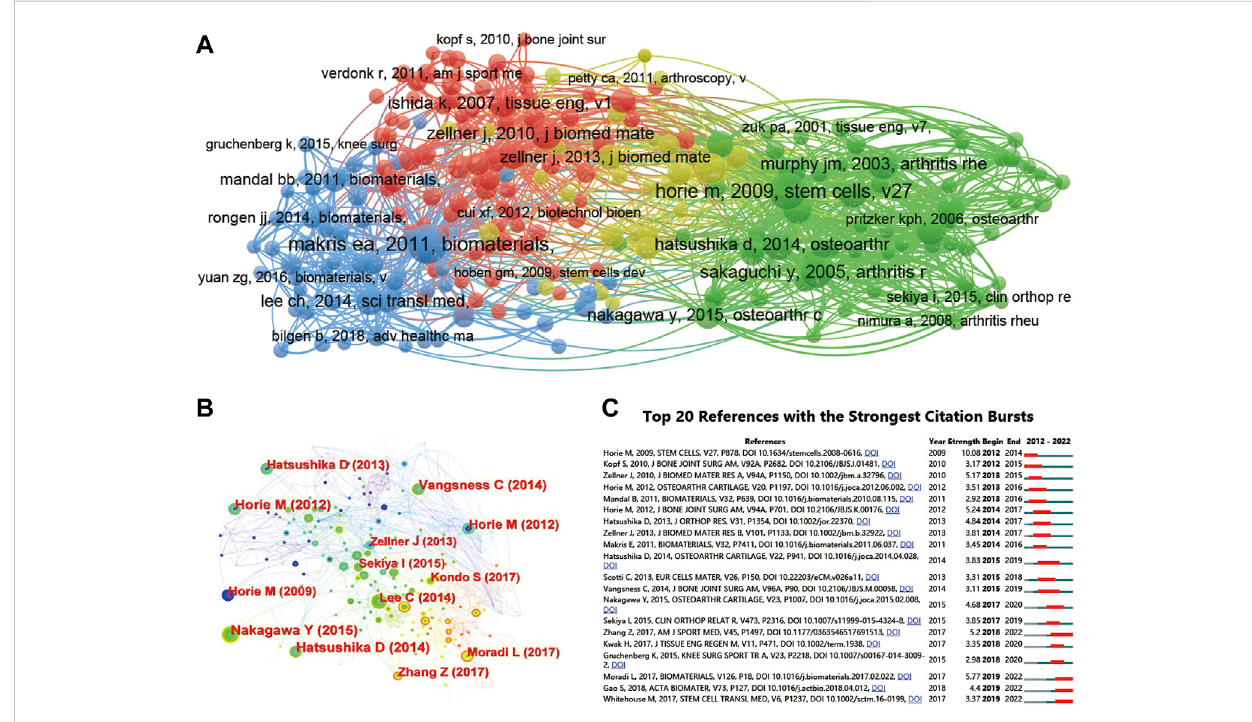
FIGURE 10 Mappingofreferencesinstudiesonstemcellsformeniscalregeneration. (A) NetworkmapofpublishingdocumentanalysisbasedonVosviewer. (B) Networkmapofcocitationanalysisofreferenceswithmorethan50citationsbasedonCiteSpace. (C) Top20referenceswiththestrongestcitationbursts of publications related to stem cells for meniscal